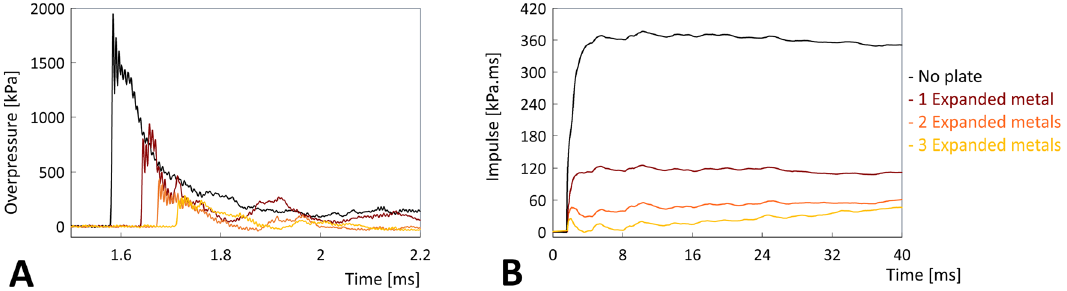
Fig. 13 Reflected overpressure ( A ) and impulse ( B ) measured on the wall positioned 50 mm behind one, two or three expanded metal plates. One reference test, which was performed without plates, is also